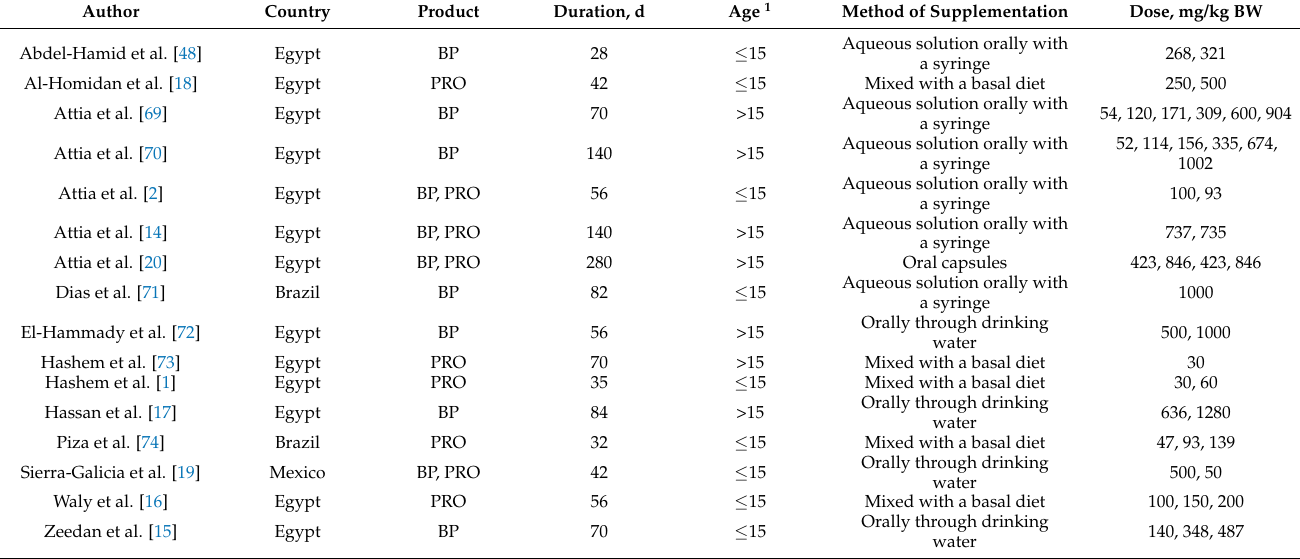
Table A1. Summary of the studies included in the meta-analysis.